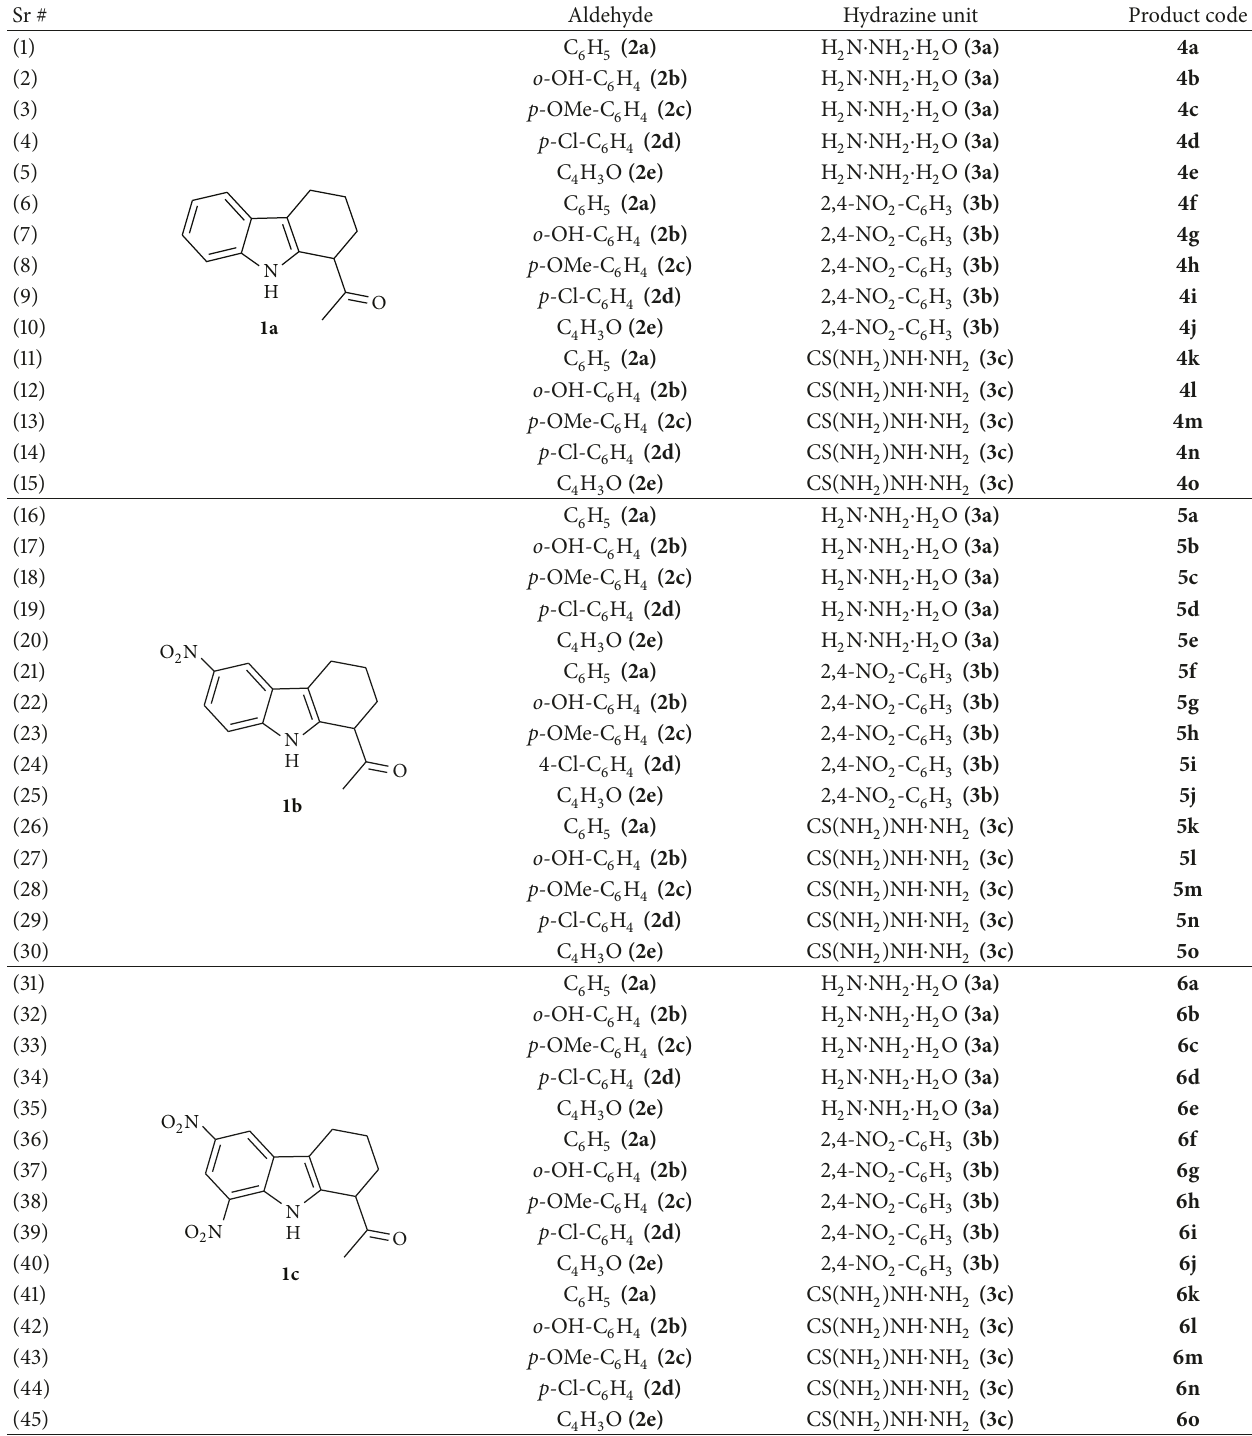
Table 1: An overview of reactants and diazoles 4/5/6(a–o)